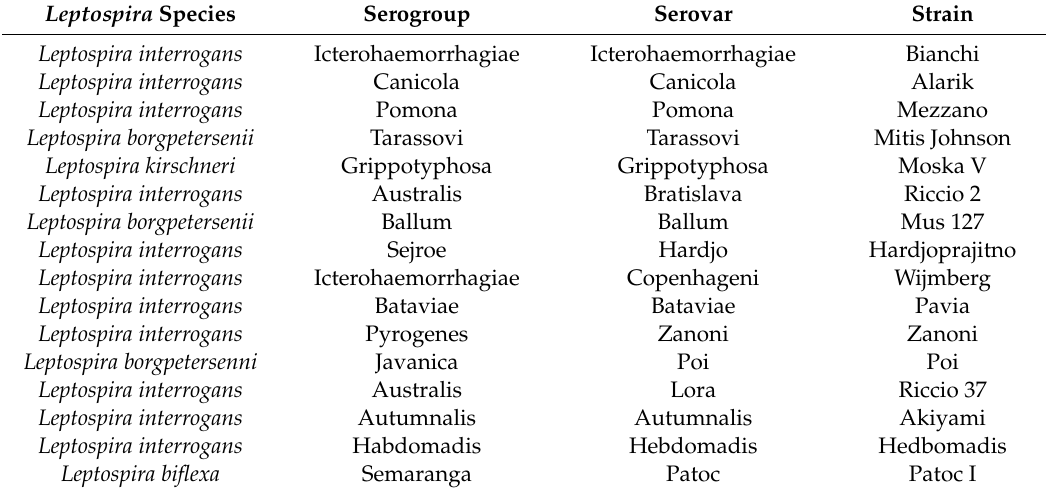
Table 1. Panel of 16 investigated Leptospira spp. strains used in this